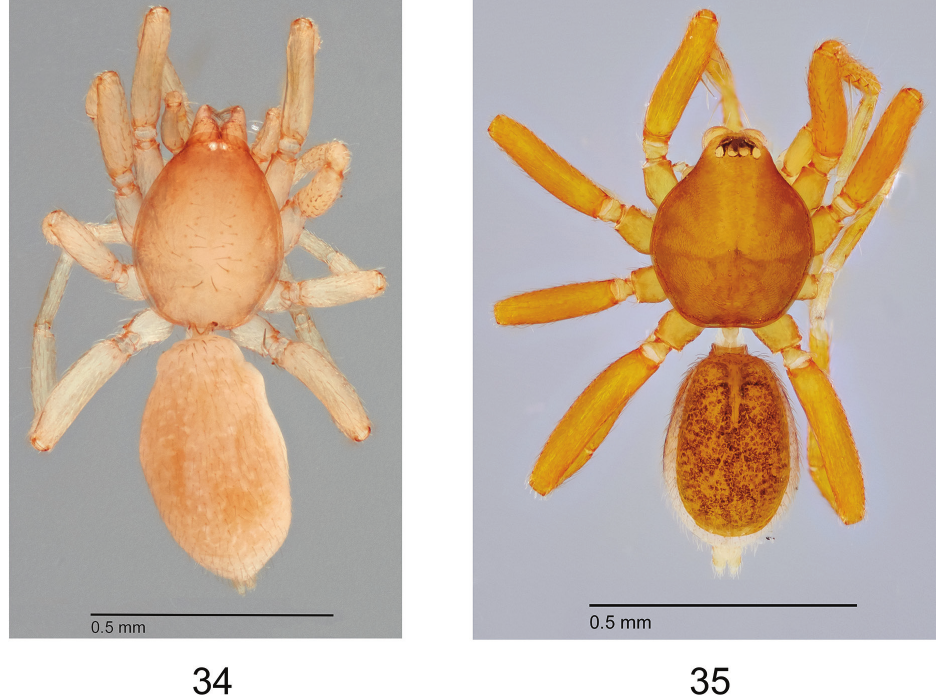
Figures 34, 35. 34. Female Reductoonops berun sp. n., dorsal view. 35. Male Bipoonops lansa sp. n., dorsal